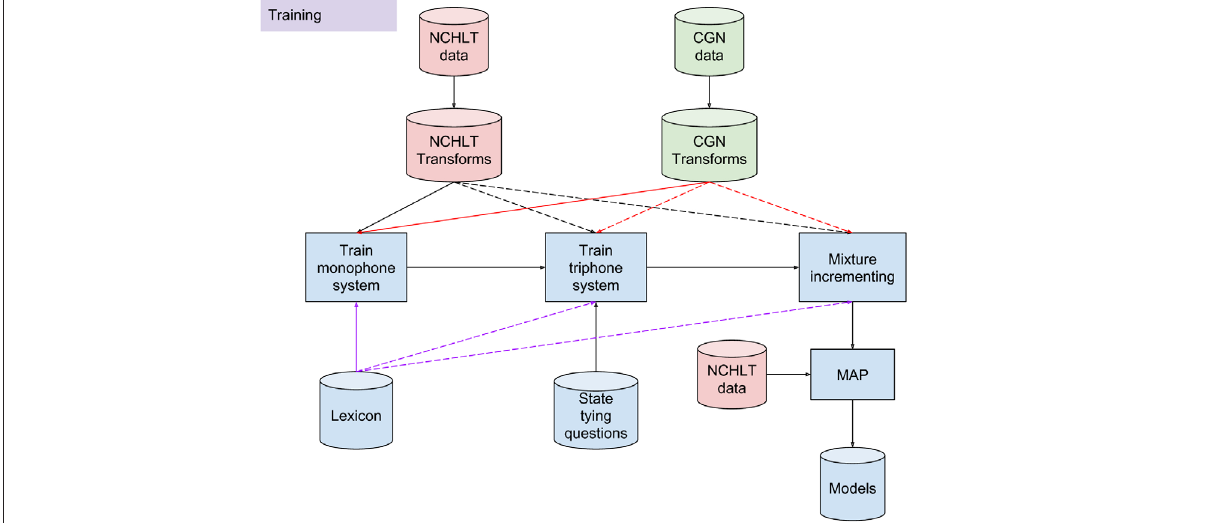
NCHLT, National Centre for Human Language Technology; CGN, Corpus Gesproken Nederlands Figure 4: Retrain using language constrained maximum likelihood linear regression transforms with maximum a posteriori (MAP) training scheme.